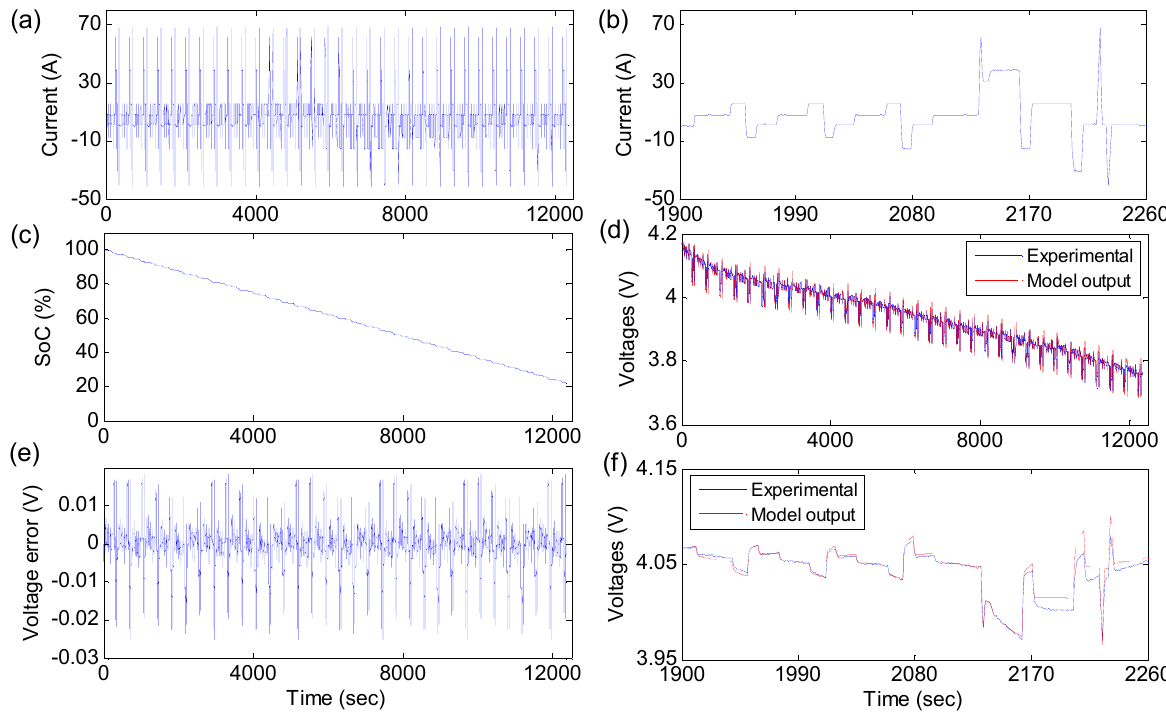
Figure 8. Model validation under DST test. ( a ) Input current profile; ( b ) Amplified current of one DST driving cycle; ( c ) SoC trajectory; ( d ) Comparison of experimental and model output voltages; ( e ) Voltage error; ( f ) Amplified experimental and model output